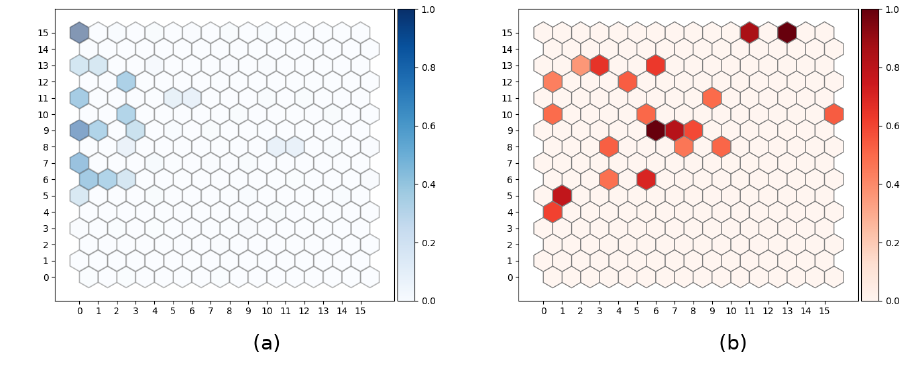
Figure 4. SOM map activation for each data sample, according to the corresponding mean quantiza- tion error. Example for EEG Delta band using 4.8 Hz stimulus. ( a ) Control ( b ) Dyslexia. As shown in Figure 4, dyslexia samples (considered as anomalies) produces a consid- erably higher quantization error than control